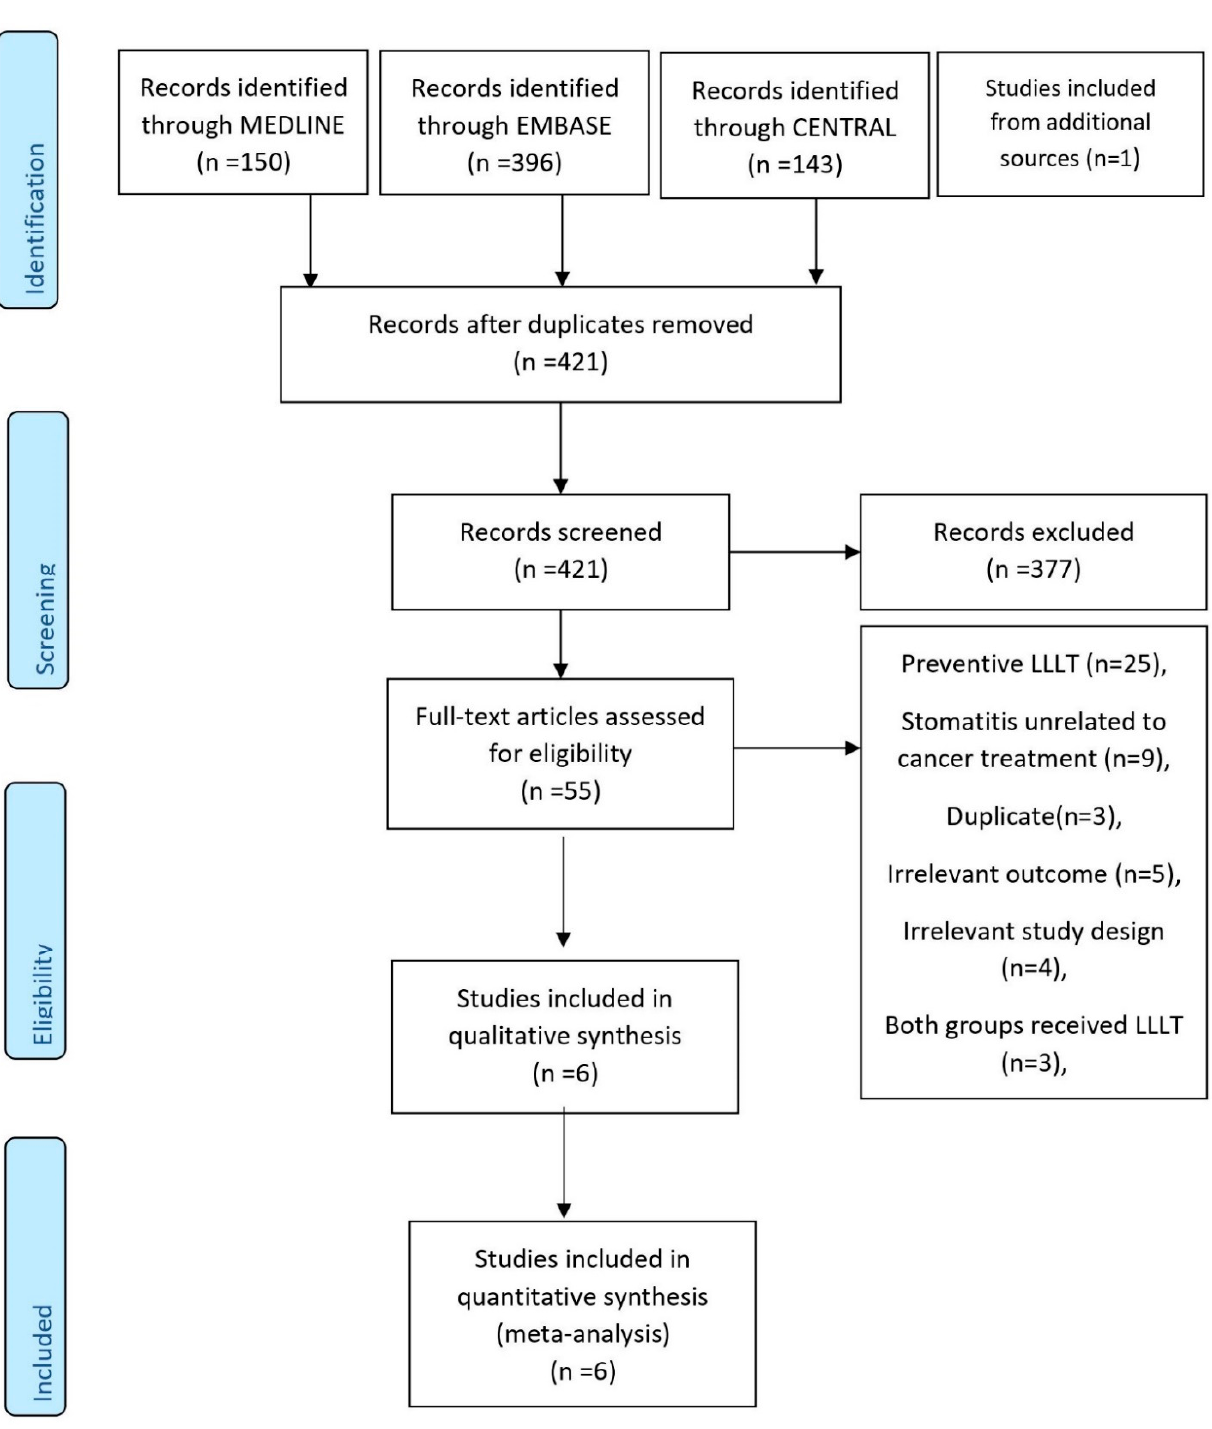
Figure 1. PRISMA flow chart for the included studies. RCT: randomized control trial, CT: chemotherapy, RT: radiotherapy, GaAIAs: gallium aluminum arsenide, He Ne; helium-neon, low-energy laser.